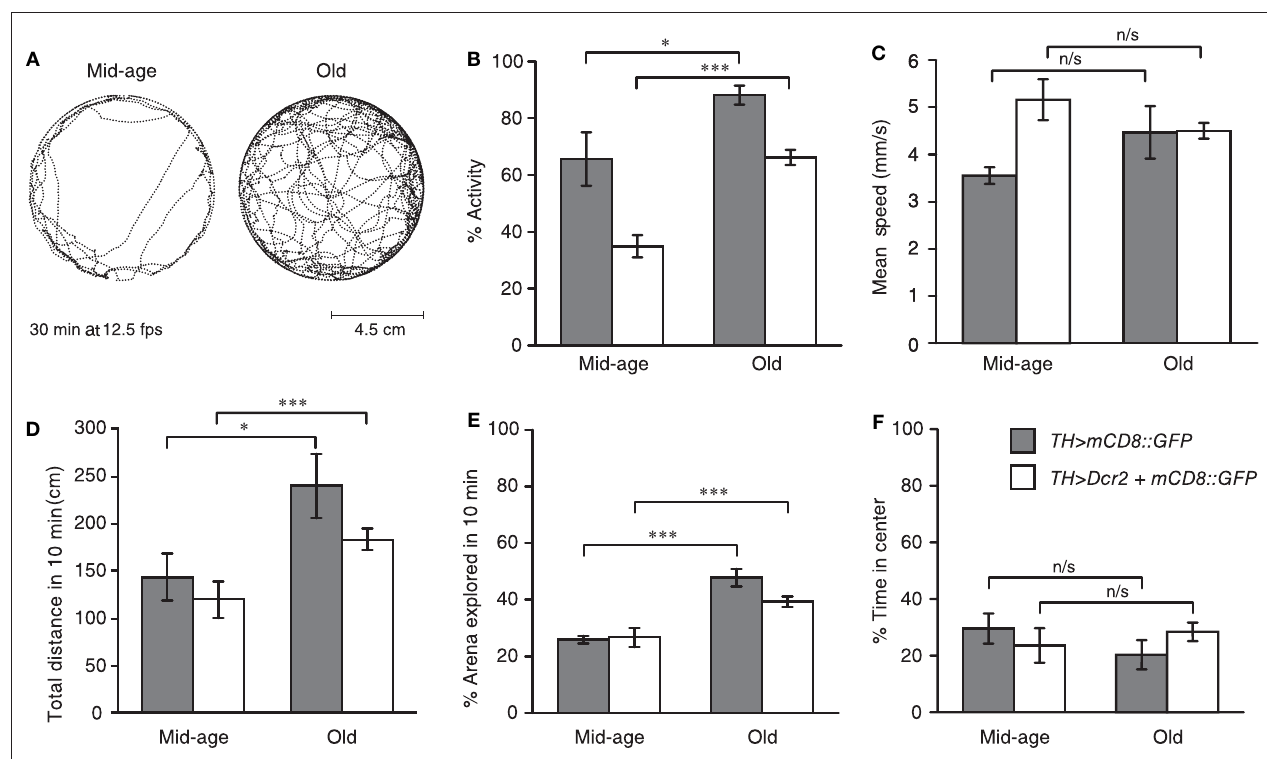
Figure 4 | Drosophila walking activity and exploration behavior but not centrophobism increase in late life and TH-specific Dcr2 expression affects distinct motor behavior. (A) Movement trajectories of mid-age (26 days) and old (62 days) heterozygous female TH > Dcr2 , mCD8 :: GFP flies recorded for 30 min at 5 frames per second (fps) in an arena (9 cm diameter). (B) Heterozygous female TH > Dcr2 , mCD8 :: GFP and TH > mCD8 :: GFP flies show in late life an increase in walking activity, but (C) not mean speed (calculated from speeds when fly is active), resulting (D) in a greater distance